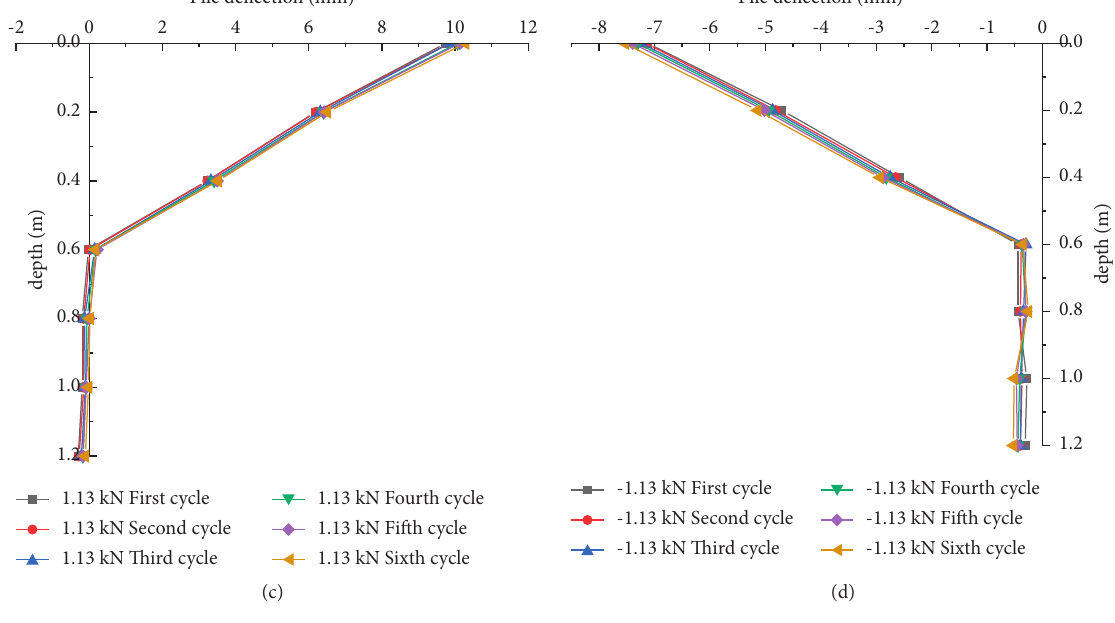
Figure 10: Deflection distribution of pile body under different cycles in the process of positive and negative loading. (a) +0.53 kN. (b) − 0.53kN. (c) +1.13kN. (d) −